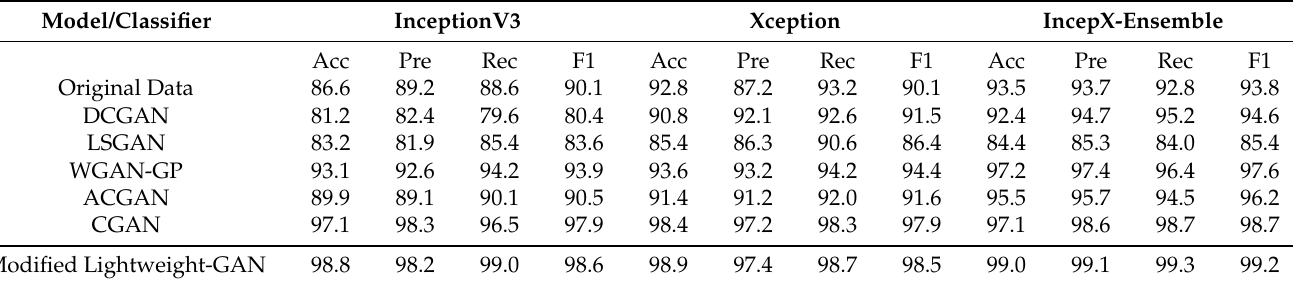
Table 5. Comparison of IncepX-Ensemble with other existing